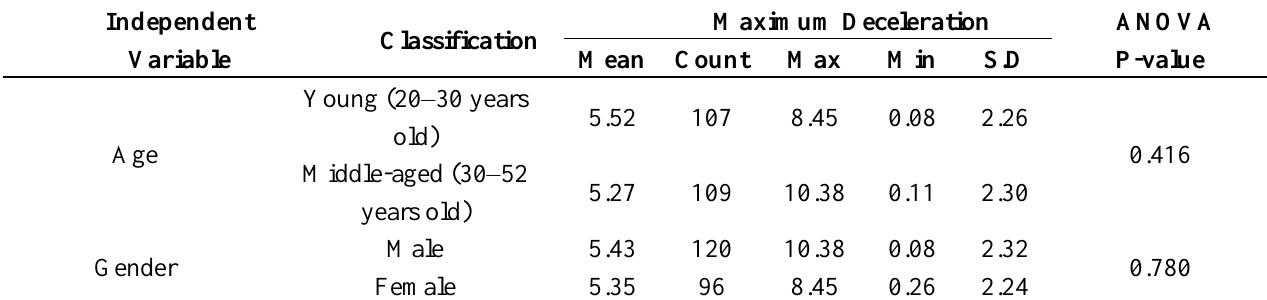
Table 7. The descriptive statistics for deceleration and ANOVA